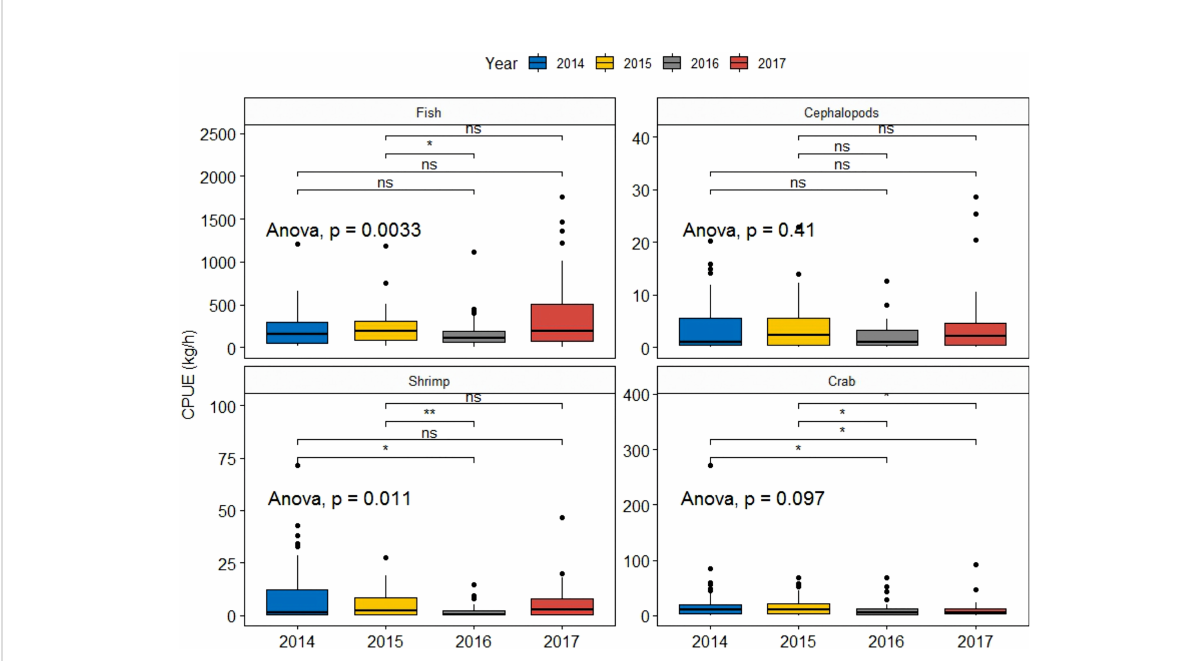
FIGURE 6 CPUE of fi sh, cephalopods, and crustaceans (shrimps, crabs) in the years before (2013 – 2014) and during (2016 – 2017) the MHW events. All pairs of groups were compared using the Kruskal – Wallis test for one-way ANOVA. * indicates signi fi cance at p<=0.05; ** indicates signi fi cance at p<=0.01; ns indicates no statistical signi fi